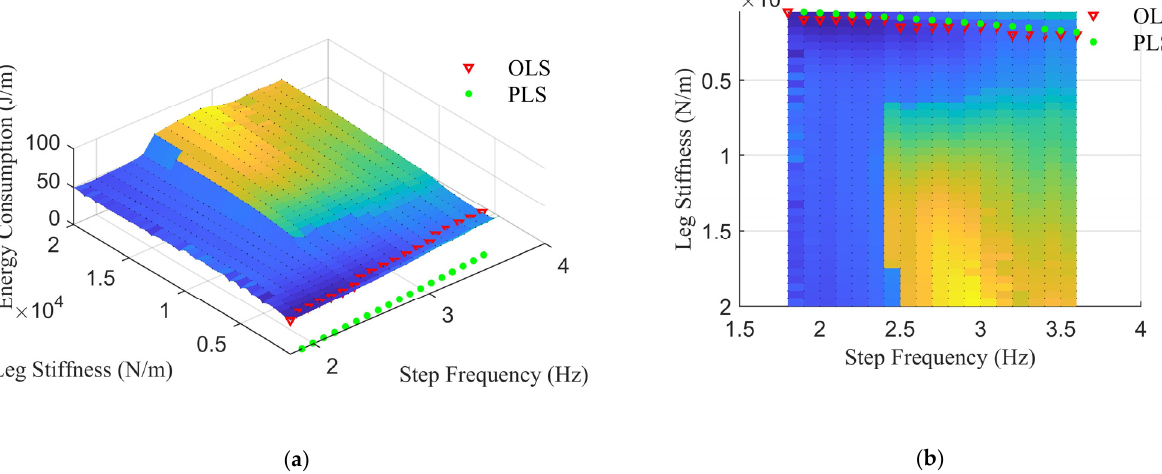
Figure 11. Energy consumption of robot locomotion with different gait frequency and leg stiffness. ( a ) Isometric view; ( b ) bottom view. The red inverted triangles denote the Optimal Leg Stiffness (OLS) for a certain gait frequency where the energy consumption is minimum; green points indicate the Preferred Leg Stiffness (PLS) obtained from the Equation (20).